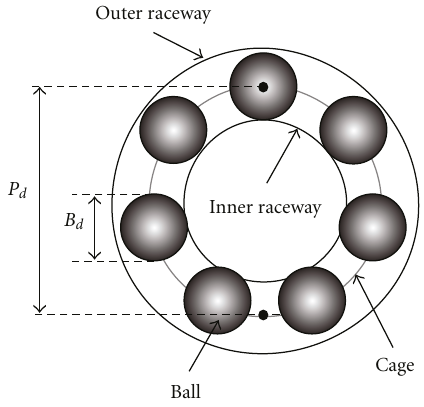
Figure 11: Structure and dimensions of a bearing.